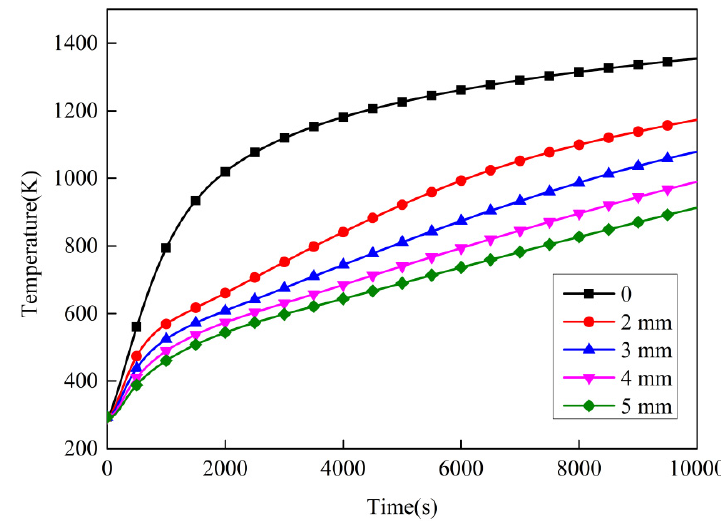
Figure 14. Location of the feature point.